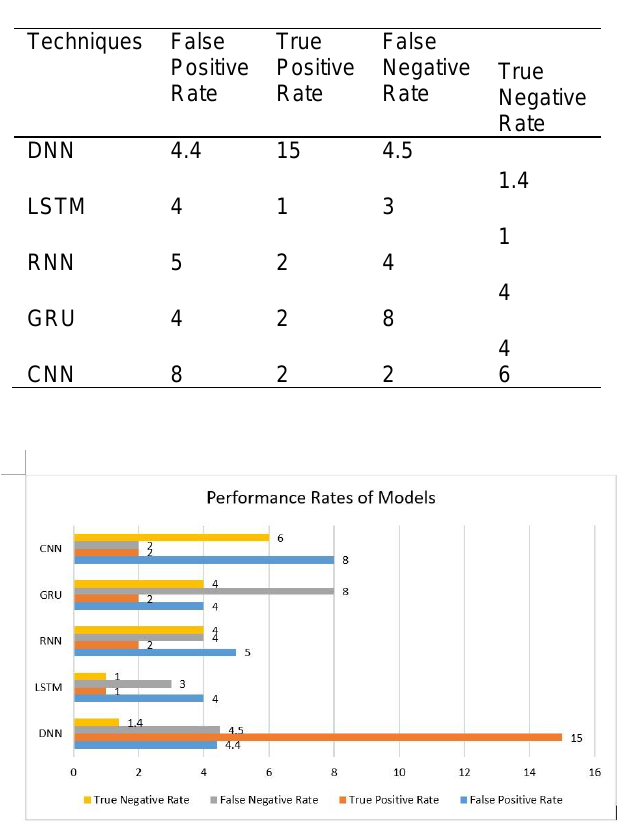
Table 1. Performance Rates of Models